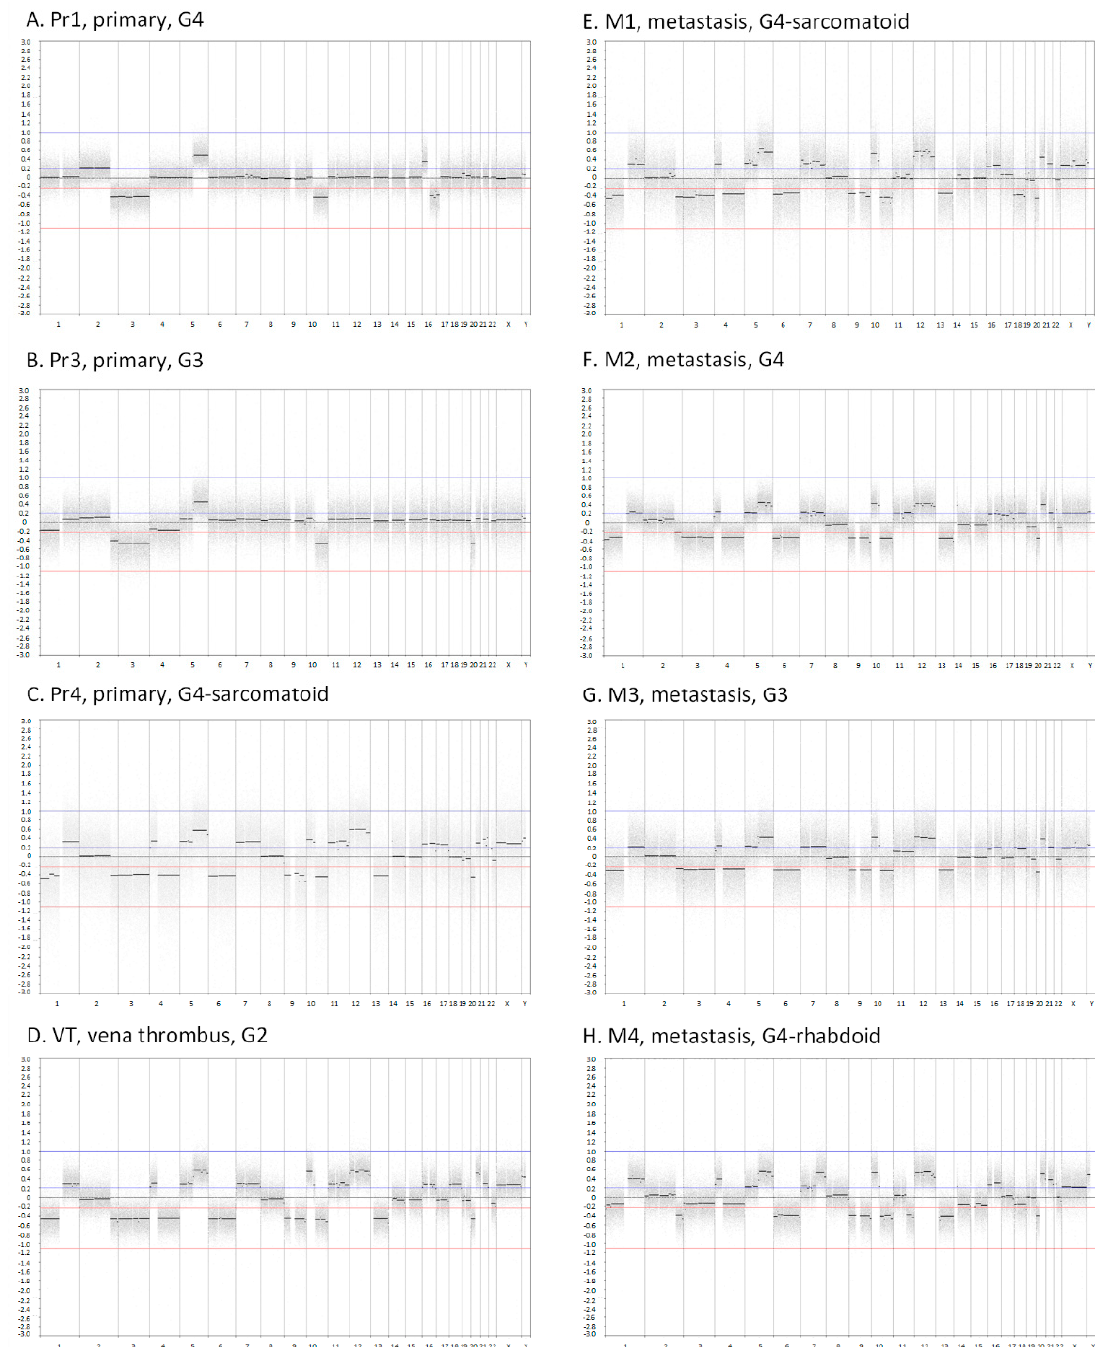
Figure 1. Array comparative genomic hybridization (CGH) plots of eight tumour samples from ccRCC patient 1 (RC1). The x -axes show the genomic position starting from 1pter until Xqter. The y -axes indicate the log2 intensity ratio between tumour and reference. Abbreviations: Pr1, primary tumour 1; Pr3, primary tumour 3; Pr4, primary tumour 4; VT, inferior vena cava tumour thrombus; M1, metastasis 1; M2, metastasis 2; M3, metastasis 3; M4, metastasis 4; G1, tumour grade 1; G2, tumour grade 2; G3, tumour grade 3; G4, tumour grade 4.